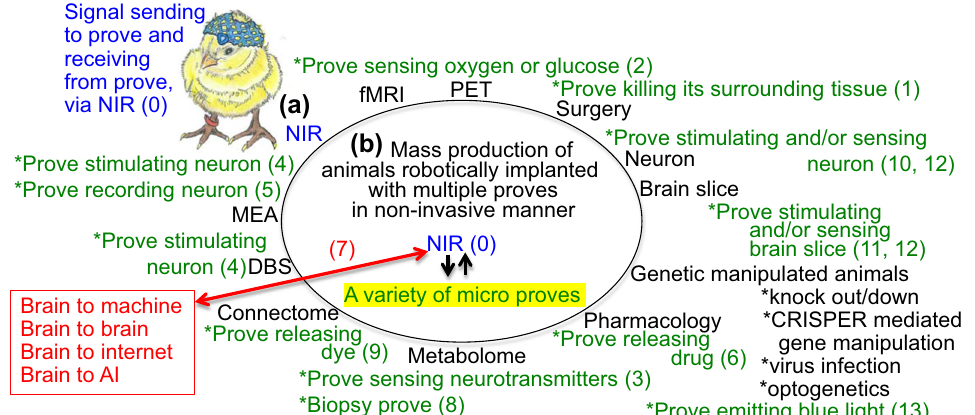
Fig. 2 The key concepts of our research -Our vision for the automation of brain research. An illustration of a chick, whose brain contains probes, wearing a blue helmet representing a near-infrared (NIR) transmitter (0), as in Fig. 1b. ( a ) NIR light should reach the deep brain of chicks (Chen et al 2018). ( b ) If hundreds of probes, devices, and electrodes are embedded in a defined area of vertebrate brain, the probes could individually communicate with the outside of the skull via NIR (0). Some existing brain research in Fig. 1 can be replaced with the NIR-driven probes